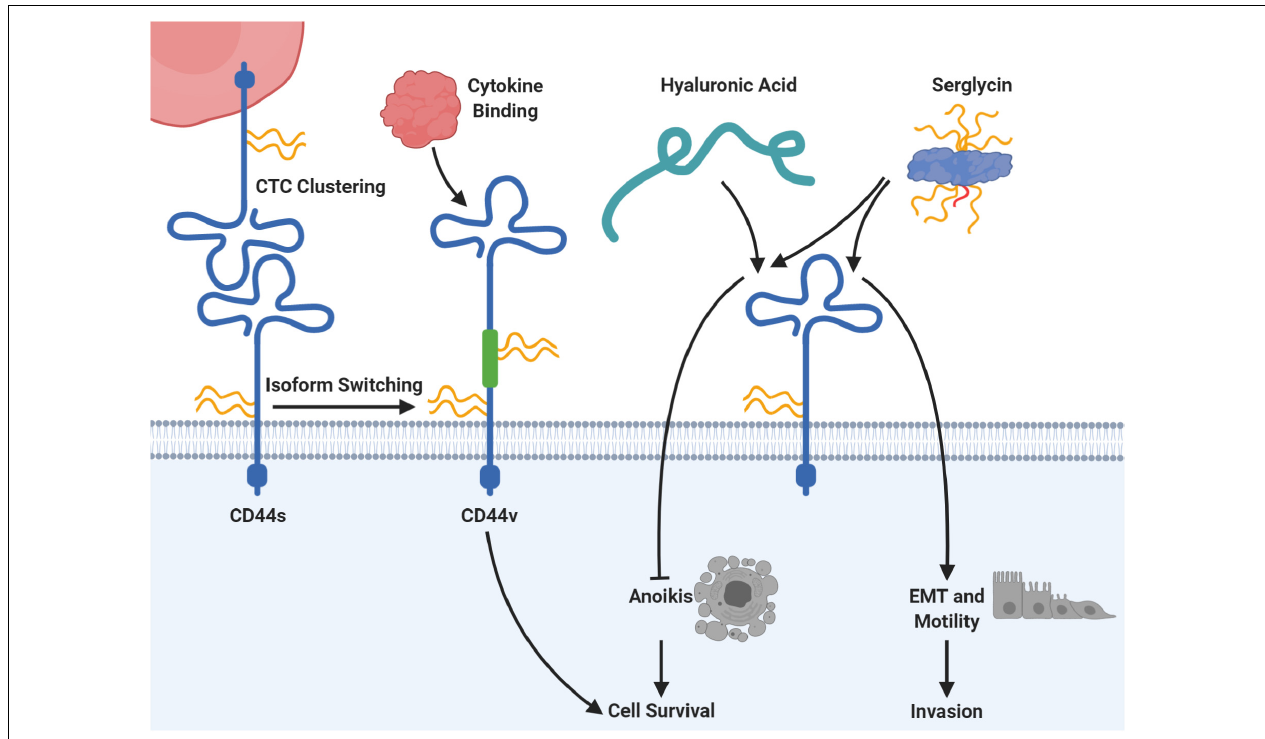
FIGURE 5 | CD44 is connected to several mechanisms of circulating tumor cell (CTC) survival and plasticity. The protein core of CD44 can carry chondroitin sulfate (CS; in yellow), heparan sulfate (HS; in red), or dermatan sulfate (DS; not shown). Homophilic CD44 interactions allow clustering of CTCs, which supports seeding and colonization at the metastatic site in mice. Moreover, expression of the standard CD44 protein form (CD44s) can be switched to expression of CD44 variants (CD44v), which include additional exons via alternative splicing (depicted in green). Those CD44v forms may carry additional glycosaminoglycan chains in dependency of the included exons and promote binding of cancer-related cytokines with downstream signaling for cell survival. The proteoglycan serglycin can carry eight glycosaminoglycan chains of heparan sulfate (HS; in red) or chondroitin sulfate (CS; in yellow) and binds to CD44. Serglycin binding to CD44 induces epithelial-mesenchymal transition (EMT) as well as cell motility and has been proven to be dependent on its CS chains. Moreover, the serglycin-CD44 interaction prevents the induction of anoikis, a specialized form of apoptosis. For this, serglycin competes with hyaluronic acid, which has the same survival promoting effect. Please refer to the specific subsections for details and